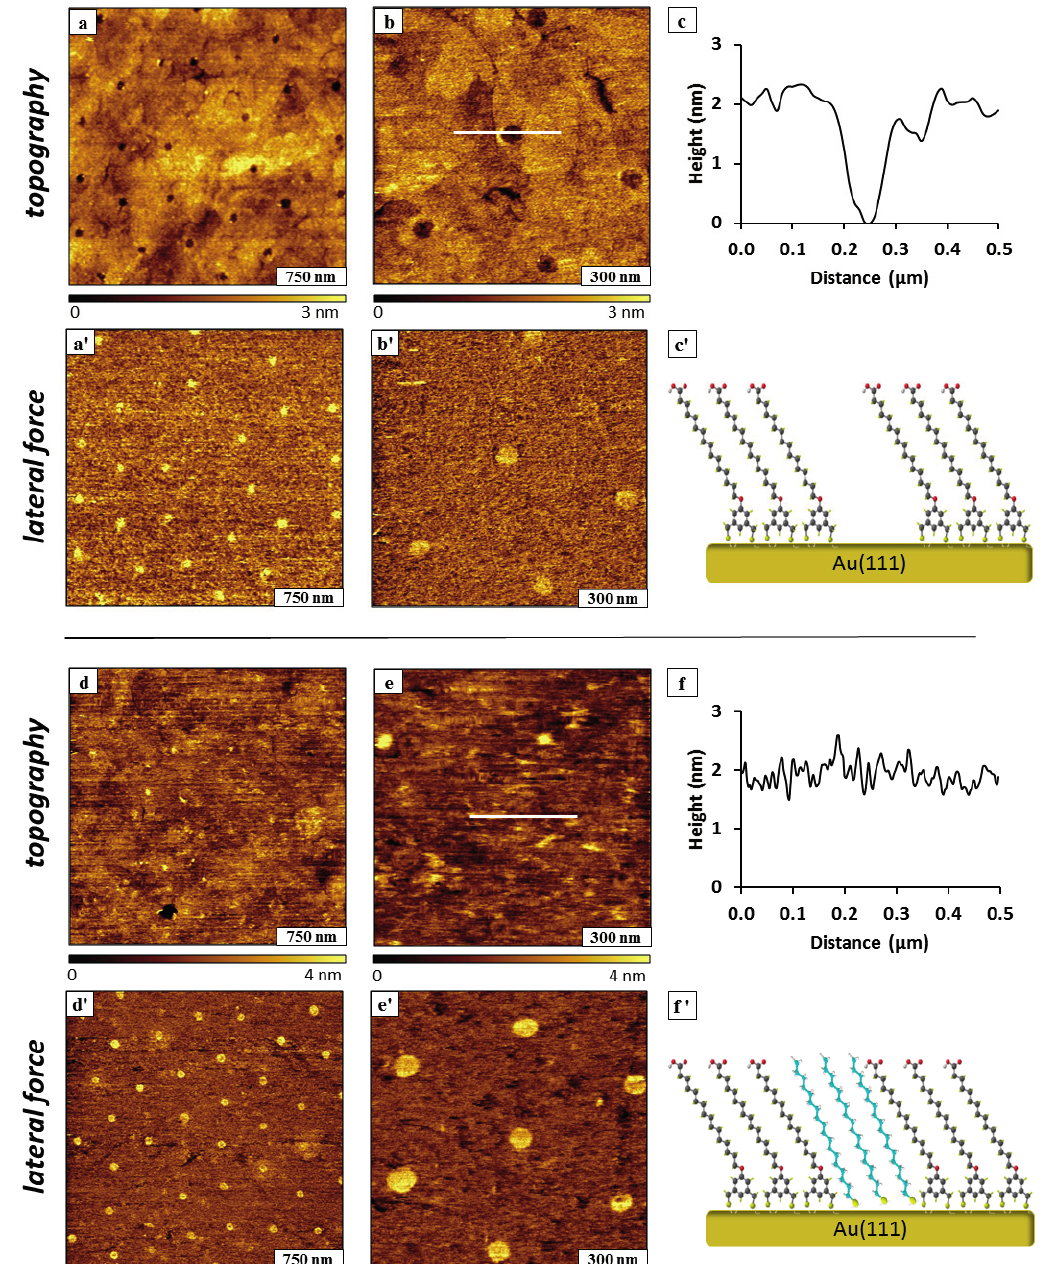
Figure 6. Nanopatterns prepared with ODT and BMPHA using immersion